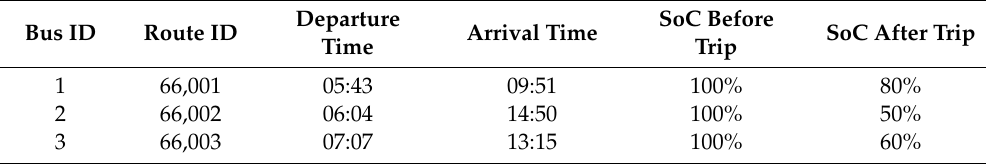
Table 2. Example of an assembled driving schedule for buses at the bus depot Alsterdorf.